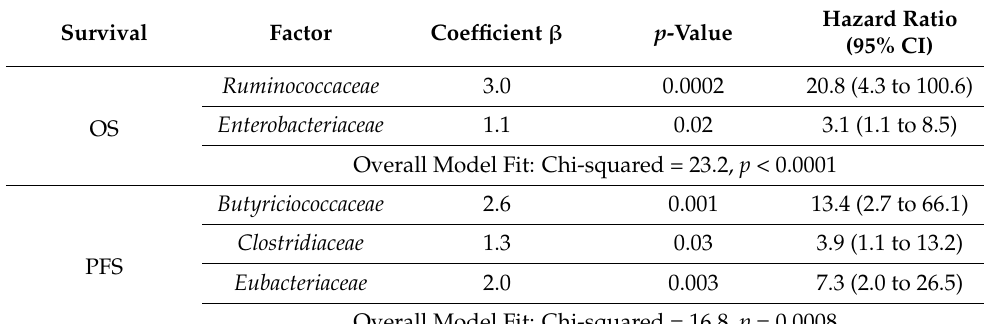
Overall Model Fit: Chi-squared = 16.8, p =